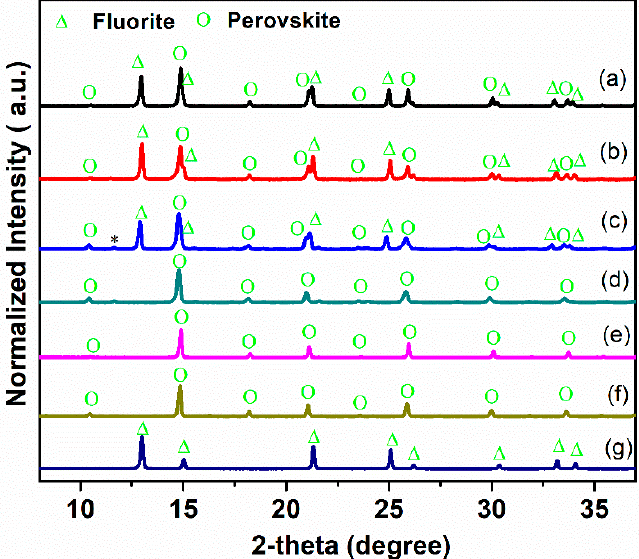
Figure 1. XRD patterns of Ce 0.9 Pr 0.1 O 2 − δ –Nd x Sr 1– x Fe 0.9 Cu 0.1 O 3 − δ ( x = 0.2, 0.5, 0.8) dual-phase